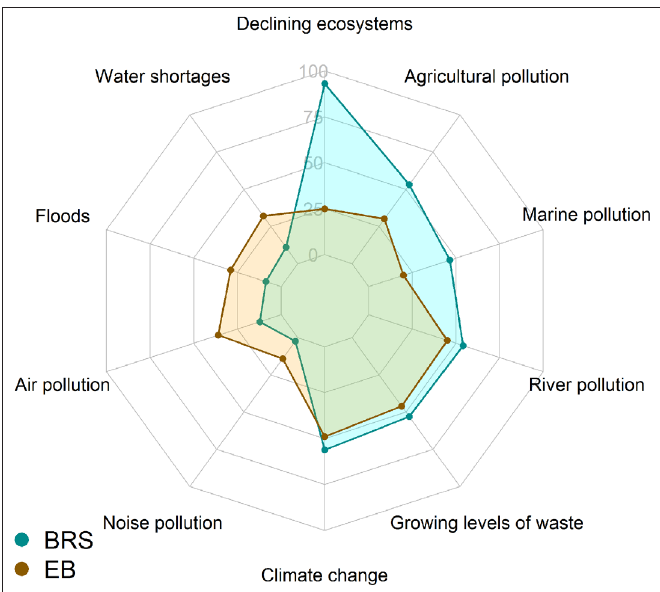
Figure 8: Environmental issues of concern for biodiversity recorders compared with those of adult population in Ireland using Eurobarometer (EB).